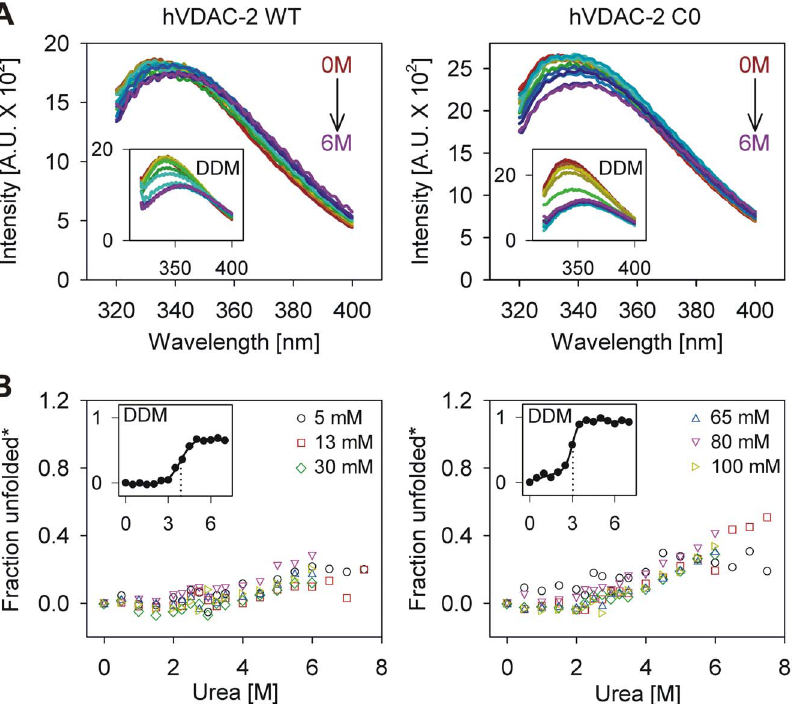
Figure 5. Equilibrium unfolding studies of refolded hVDAC-2 in urea. (A) Representative Trp fluorescence wavelength scans of hVDAC-2 WT (left) and C0 (right) refolded in 13 mM LDAO and 0.2 % DDM (shown as insets) after 1 h incubation at 25 u C in a urea gradient. Note the heavy overlap in the emission spectra in the case of LDAO refolded samples, with only a marginal red shift of the l em-max ( , 3–4 nm), suggesting that hVDAC-2 does not undergo significant protein unfolding in this condition. However, samples in DDM (insets) display a . 15 nm red-shifted l em-max accompanied by a significant reduction in the emission intensity in higher urea concentrations, indicative of substantial barrel unfolding. (B) Plot of unfolded fractions for hVDAC-2 WT (left) and C0 (right) calculated using 340 nm intensity values, in the various LDAO concentrations used in this study, after 1 h incubation at 25 u C in urea. The unfolded fractions were calculated by using values for the unfolded protein from GdnHCl, and are hence indicated by (*). LDAO underwent precipitation above 6 M urea in concentrations . 13 mM; hence these values are not included in the final analysis. This precipitation appears to be a property of LDAO when both the detergent and urea are in high concentrations, as it was also observed in samples without the protein. Data points shown are the mean of three datasets. Error bars are omitted for clarity. The insets show the corresponding unfolded fractions calculated for urea denatured hVDAC-2 WT and C0 refolded in 0.2% DDM, obtained under similar experimental conditions and analyzed as described for LDAO. Solid lines represent fits to a two-state equation, and the dotted line highlights the calculated C m . Note that the extent of unfolding of C0 is greater in LDAO and DDM (compare fraction unfolded* values of WT and C0 in 4 – 8 M urea). Furthermore, the C m of C0 is lower than WT in DDM (3.9 M for WT and 3.0 M for C0).